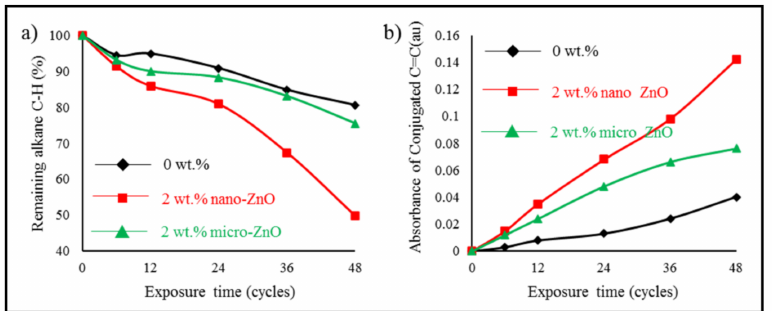
Figure 5. ( a ) Changes of alkane C-H and ( b ) conjugated C=C groups in the coatings with (2 wt.%) or without (0 wt.%) ZnO particles during the UV/CON